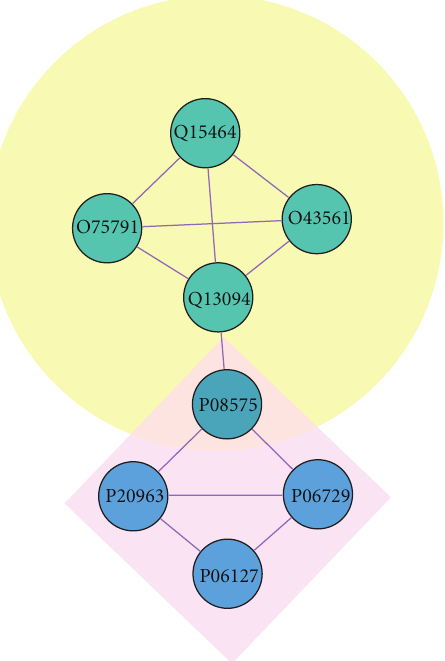
Figure 9: Two overlapping modules shared one protein P08575. The yellow module works on T cell activation and the pink module take part in B cell